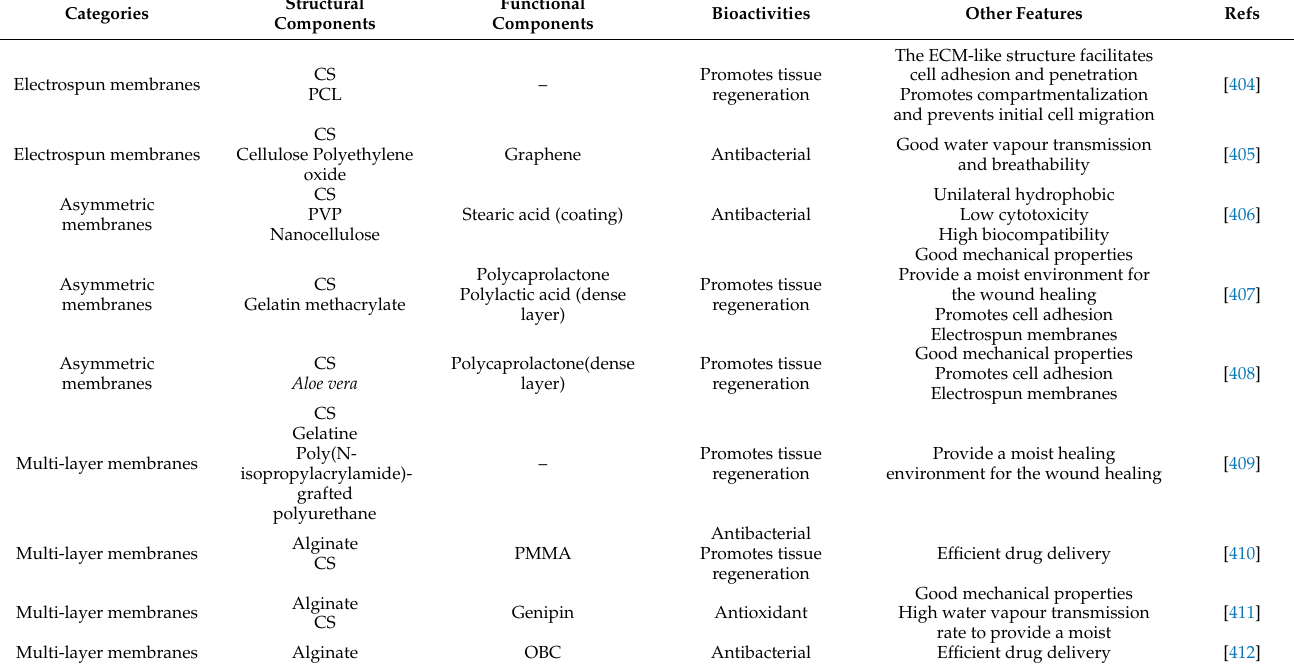
Table 9. Summary of raw materials and characteristics of MPs membranes dressings in recent